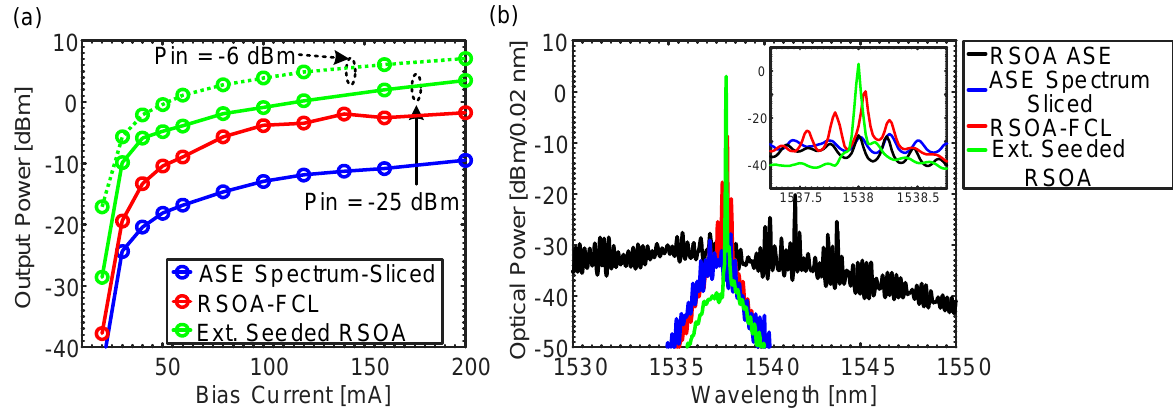
Figure 9. Experimental characterization: ( a ) shows measured optical power versus bias current for the ASE spectrum-sliced, the self-seeded RSOA-FCL and the externally seeded RSOA colorless transmitters; ( b ) shows the corresponding spectrum at a bias current of 100 mA. The inset shows a zoomed-in plot for the three